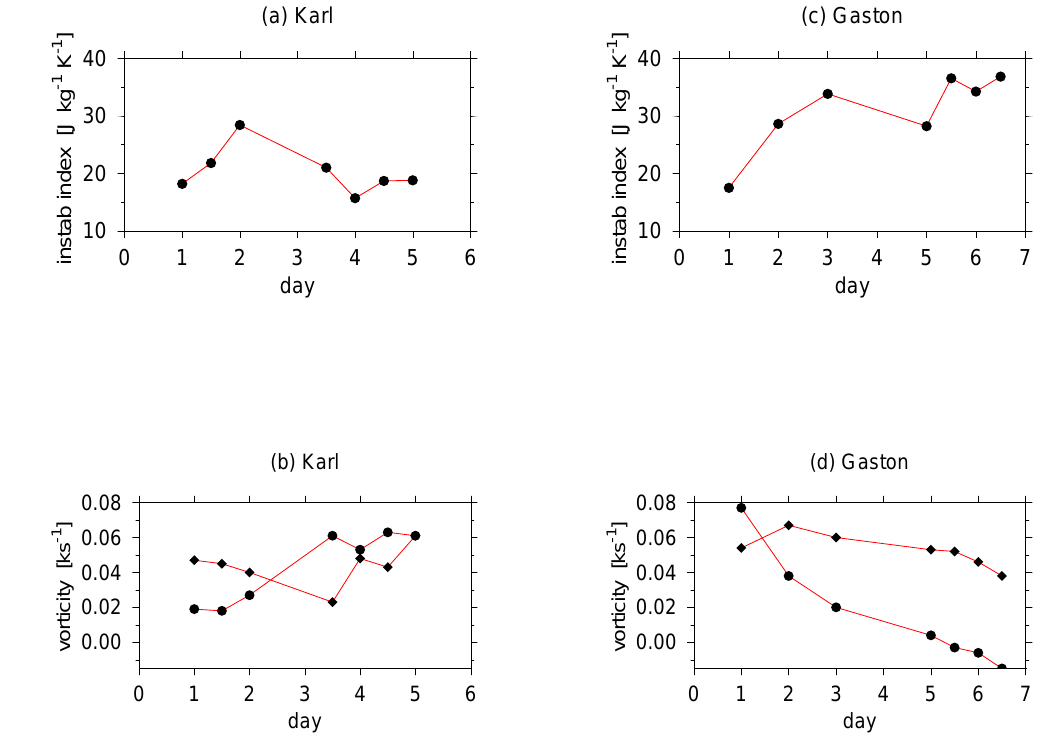
Fig. 3. Horizontally averaged (a) relative vertical vorticity, (b) vertical mass flux, (c) vorticity tendency, and (d) relative humidity for all the Gaston missions.